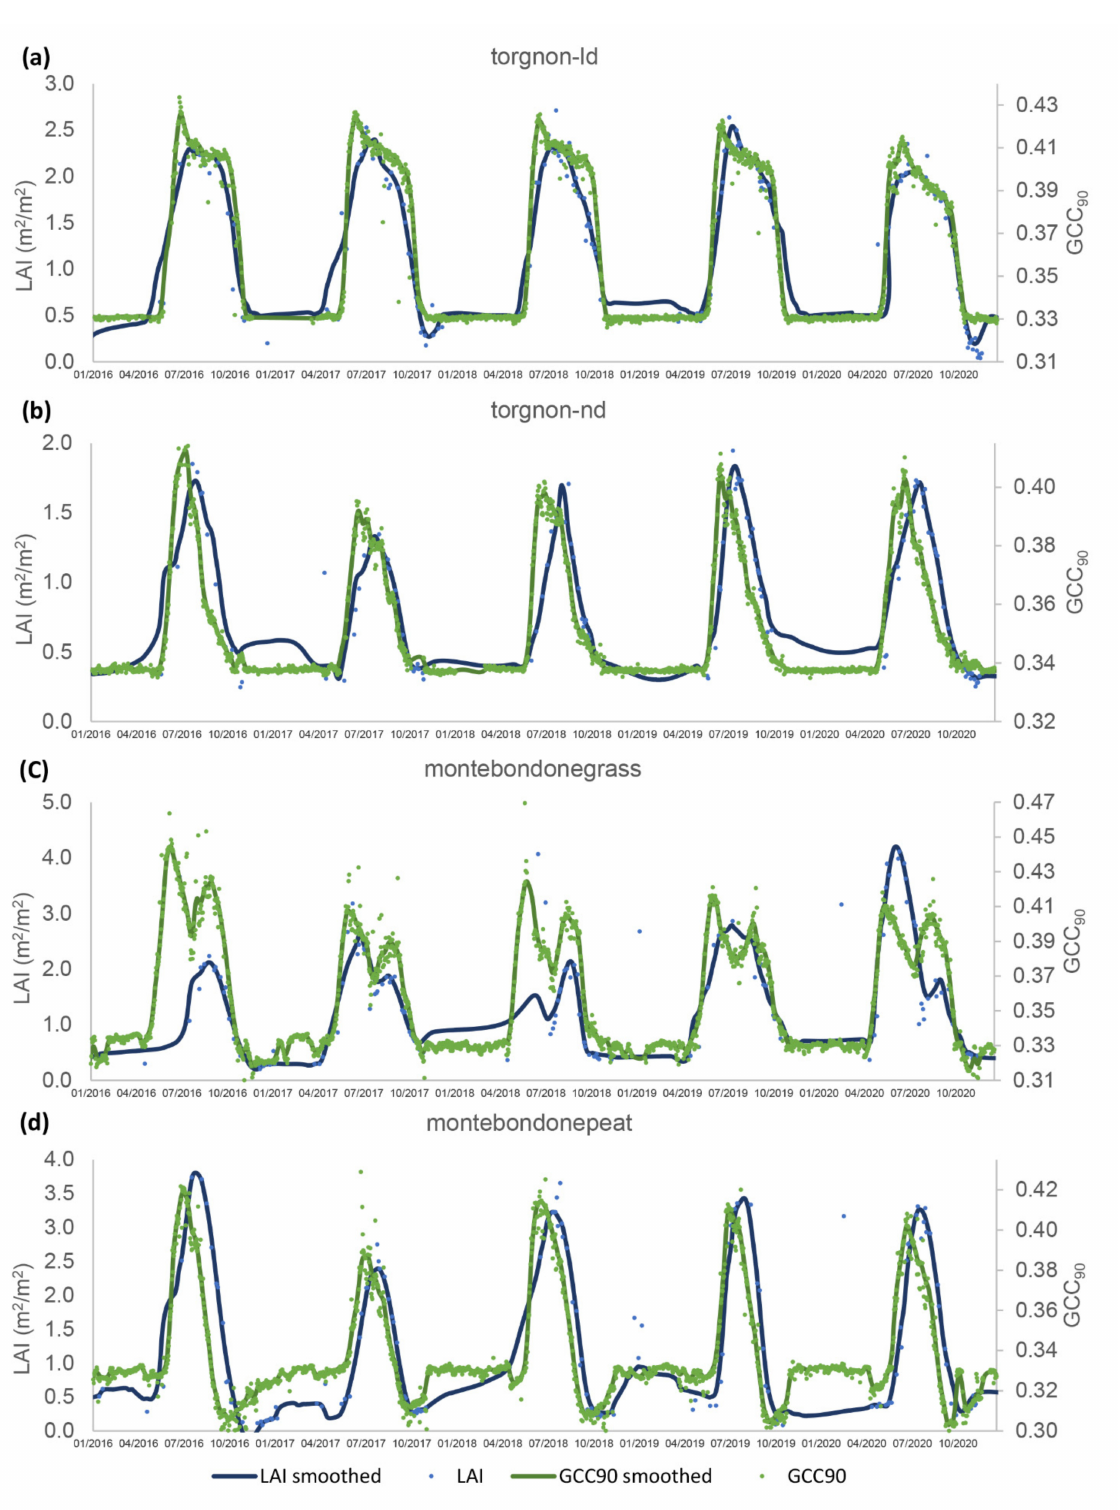
Figure A1. Comparison of PhenoCam GCC 90 time series with the corresponding S2 LAI time series for the period 2016–2020 in the four Italian PhenoCam sites. ( a ) torgnon-ld site; ( b ) torgnon-nd site; ( c ) montebondonegrass site; ( d ) montebondonepeat